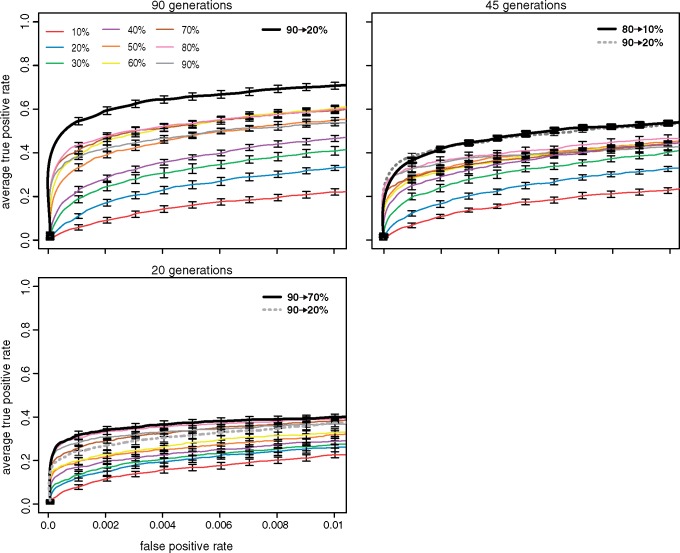
Influence of the number of generations (default = 90). The performance of the best increasing regime (black, bold), the 90 → 20% increasing regime (gray, dashed), and the constant regimes (different colors) is shown. Although increasing regimes consistently perform best, the advantage of an increasing regime is most pronounced for long E&R studies.